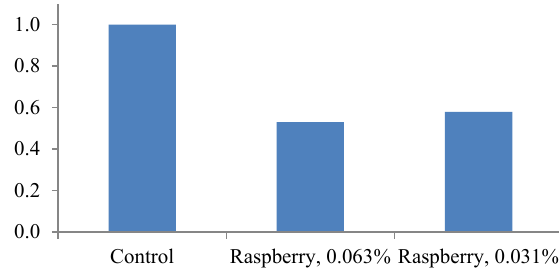
Figure 4 Effect of the raspberry extract on iNOS expression. The quantitative PCR analysis of iNOS expression was performed after HCT-116 cells had been incubated for 24 hours at working concentrations (0.063% and 0.031%). The number of PCR products was assessed and normalized according to the amount of the PCR product of the Rpl27 gene